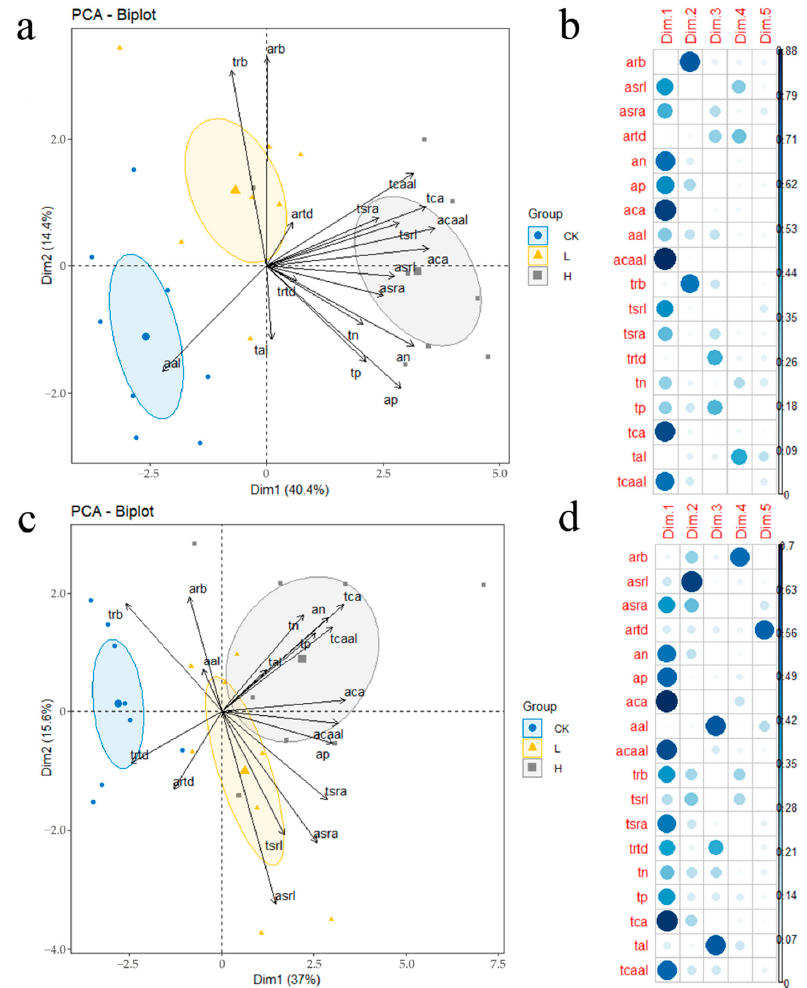
Figure 3. Principal component analysis for root traits of Chinese fir in mildly and severely acidified soil. CK, L, and H respectively represent three treatments (CK, control; L, low CaCO 3 addition; H, high CaCO 3 addition) in mildly ( a ) and severely ( c ) acidified soil samples; Figure ( b , d ) show the cos2 (quality of representation of the variables on factor map) of variables on all the dimensions of Figure ( a , c ), respectively. A high cos2 value indicates a good representation of the variable on the principal component. The size of circles and the shades of color is proportional to the value of cos2. arb/trb, root biomass of AR/TR; asrl/tsrl, root SRL of AR/TR; asra/tsra, root SRA of AR/TR; atrd/trtd, root RTD of AR/TR; aca/tca, root Ca concentration of AR/TR; aal/tal, root Al concentration of AR/TR; an/tn, root N concentration of AR/TR; ap/tp, root P concentration of AR/TR; acaal/tcaal, root Ca/Al ratio of